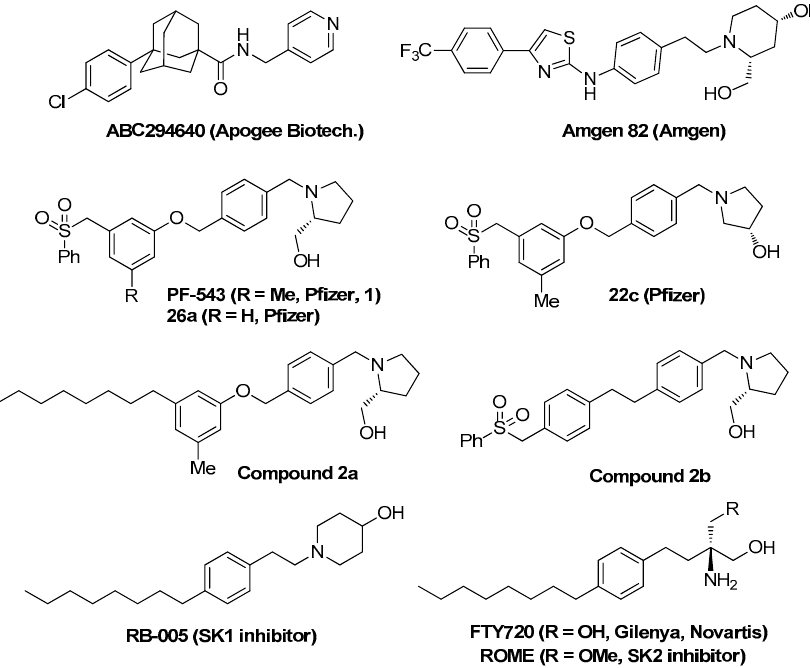
Figure 1. Known sphingosine kinase inhibitors and FTY720.